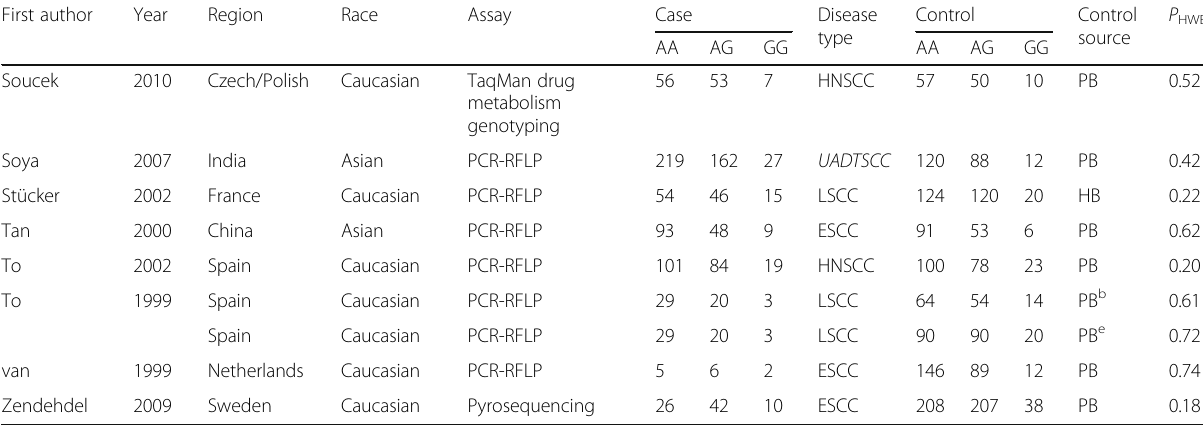
Table 1 Basic information of the eligible articles in the meta-analysis (Continued)